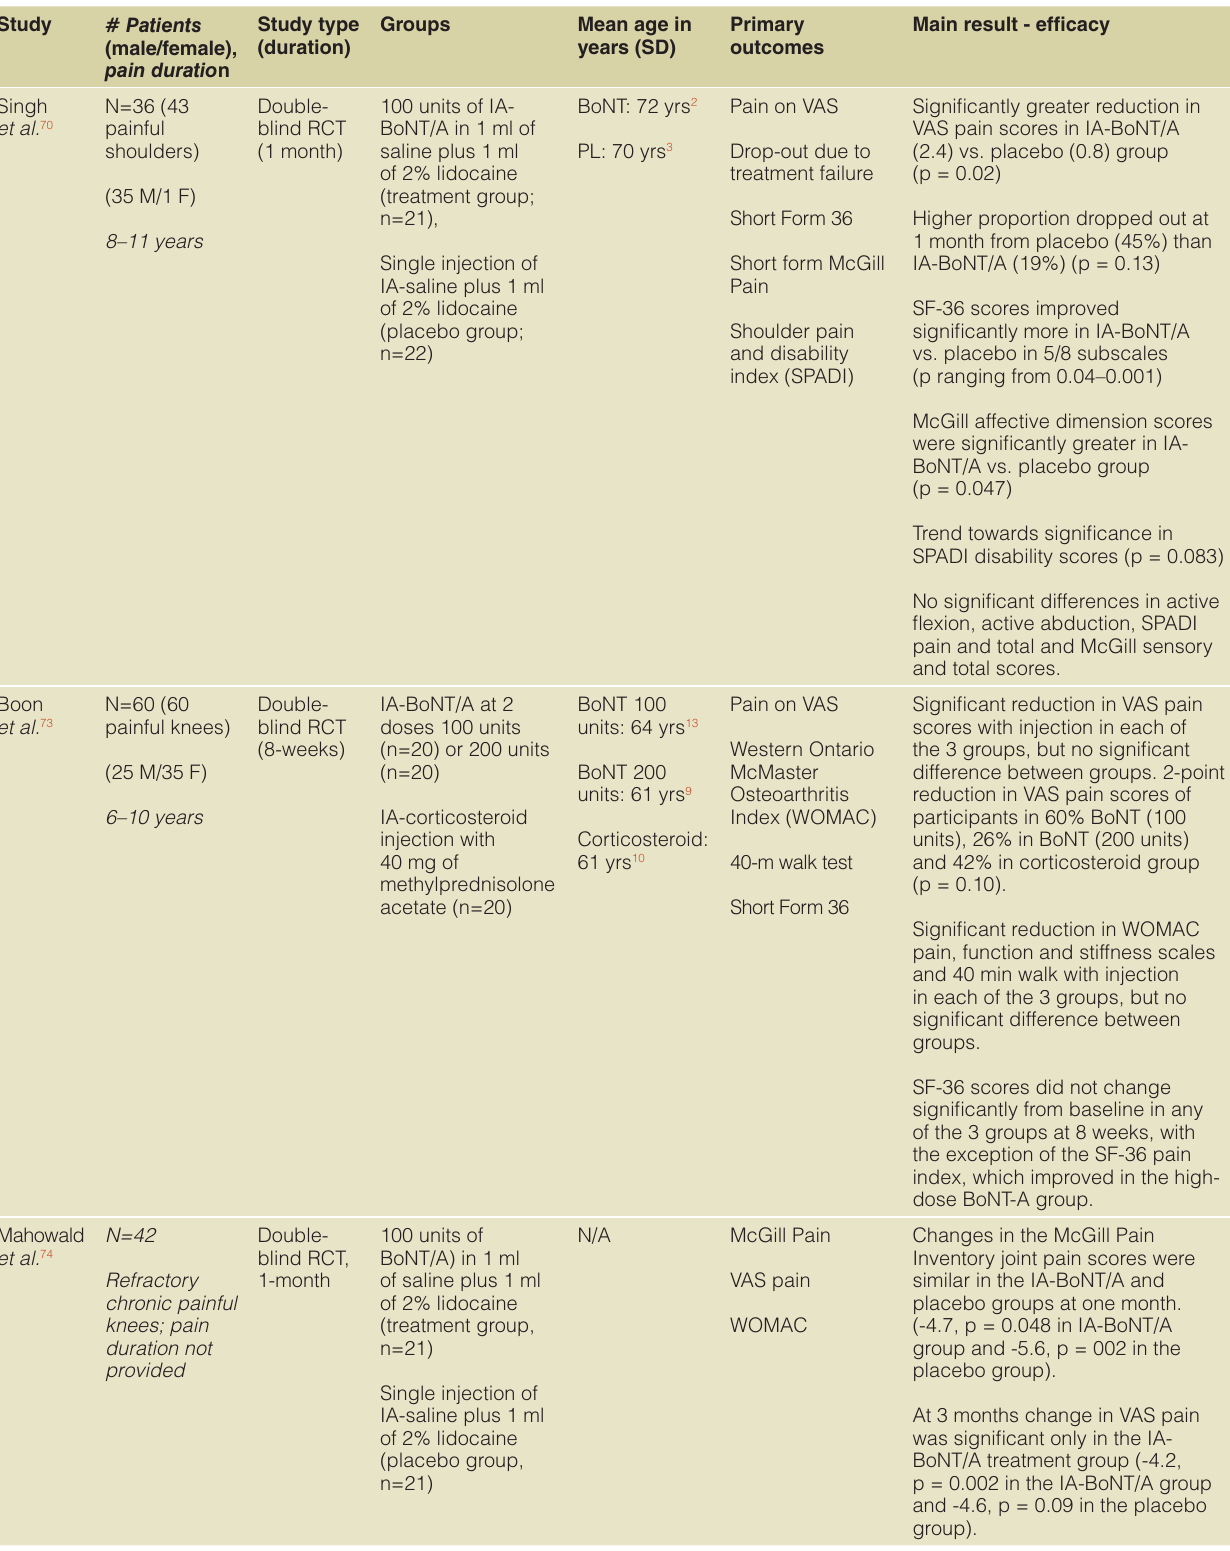
Table 1. Efficacy of botulinum toxin in osteoarticular pain in randomized controlled trials.